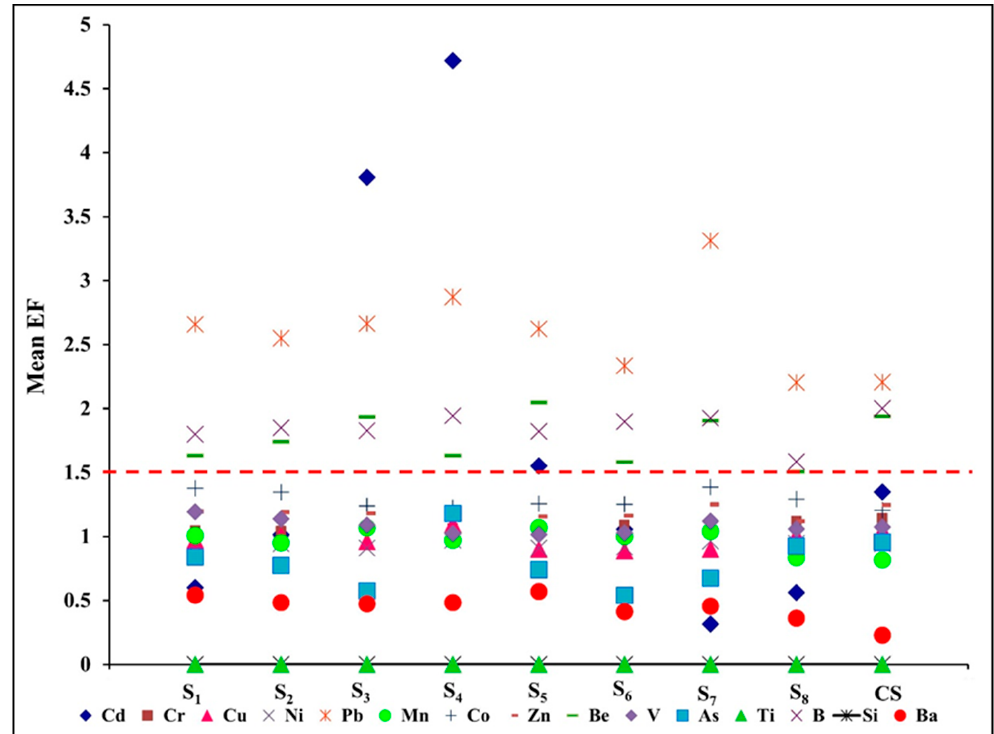
Figure 5. Enrichment factor (EF) of trace elements present in surface sediments.